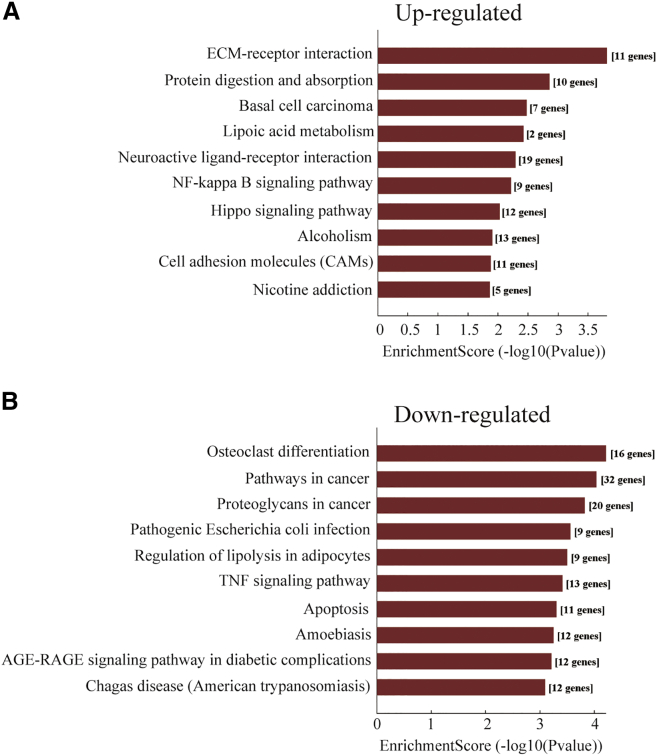
KEGG Analysis of the MicroRNA-mRNA network.(A and B) KEGG pathway enrichment analysis of upregulated (A) and downregulated (B) mRNAs with the top ten enrichment scores was performed. Both up- and downregulated mRNAs are significantly changed, with fold change > 2.0, p < 0.05 between OLF and normal LF tissues.